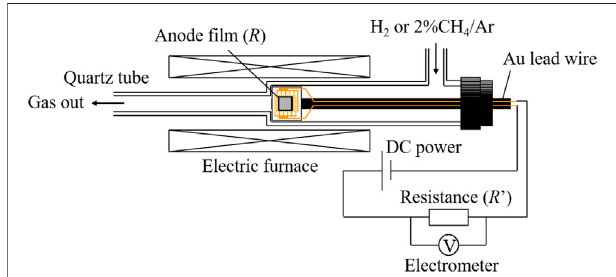
FIGURE2| ThesetupofDCresistancemeasurementfortheanode fi lms formed on the comb-type Au electrode under H 2 and 2%CH 4 /Ar fl ow.